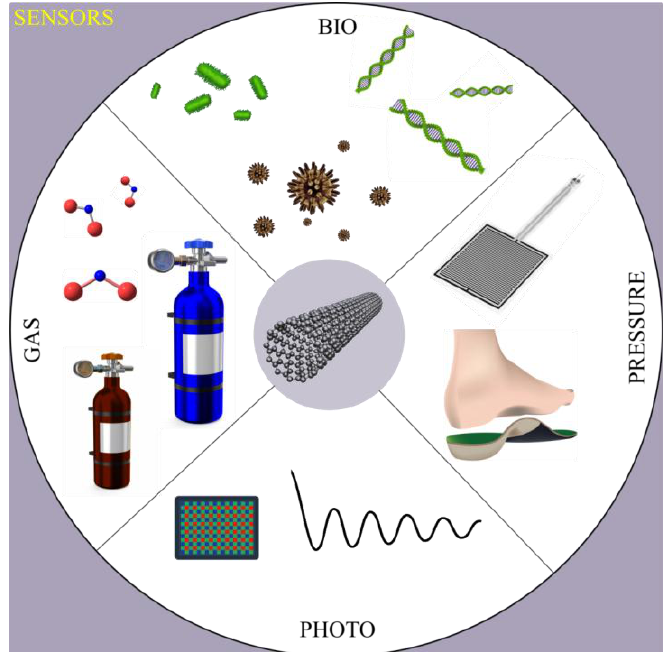
Figure 1. Carbon nanotubes have been used for a number of different applications. When it comes to sensing devices, they have been used to realize gas sensors, biosensors, pressure sensors and